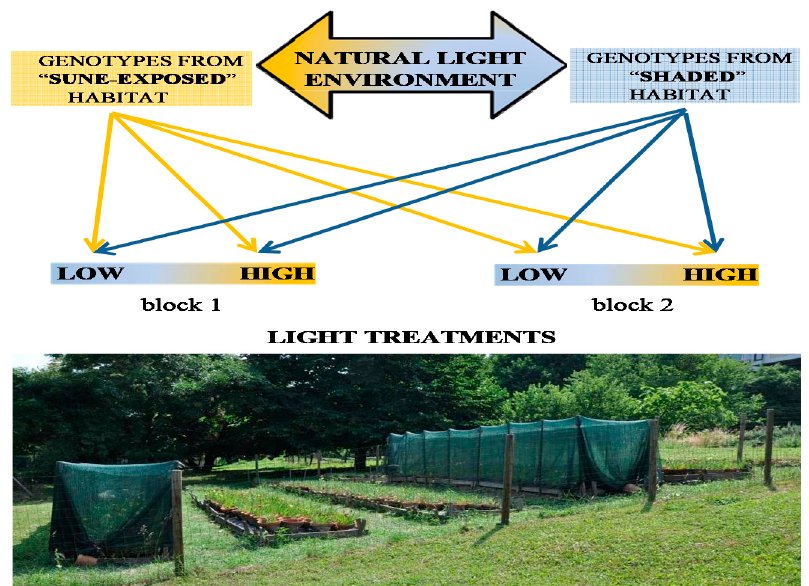
Figure 4. Experimental design at the experimental garden within the Institute for Biological Research “Siniša Stankovi´c”, University of Belgrade, Serbia where a total of 68 genotypes of I. variegata were grown.